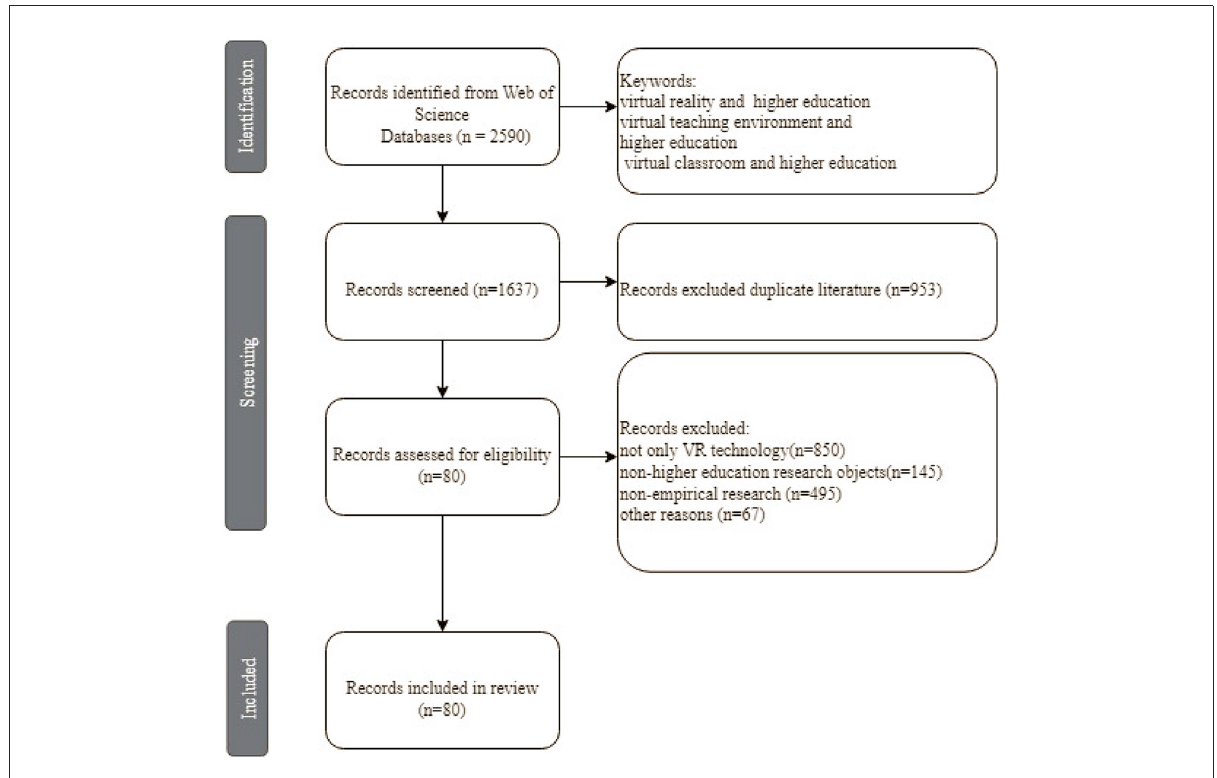
FIGURE1 Literature inclusion